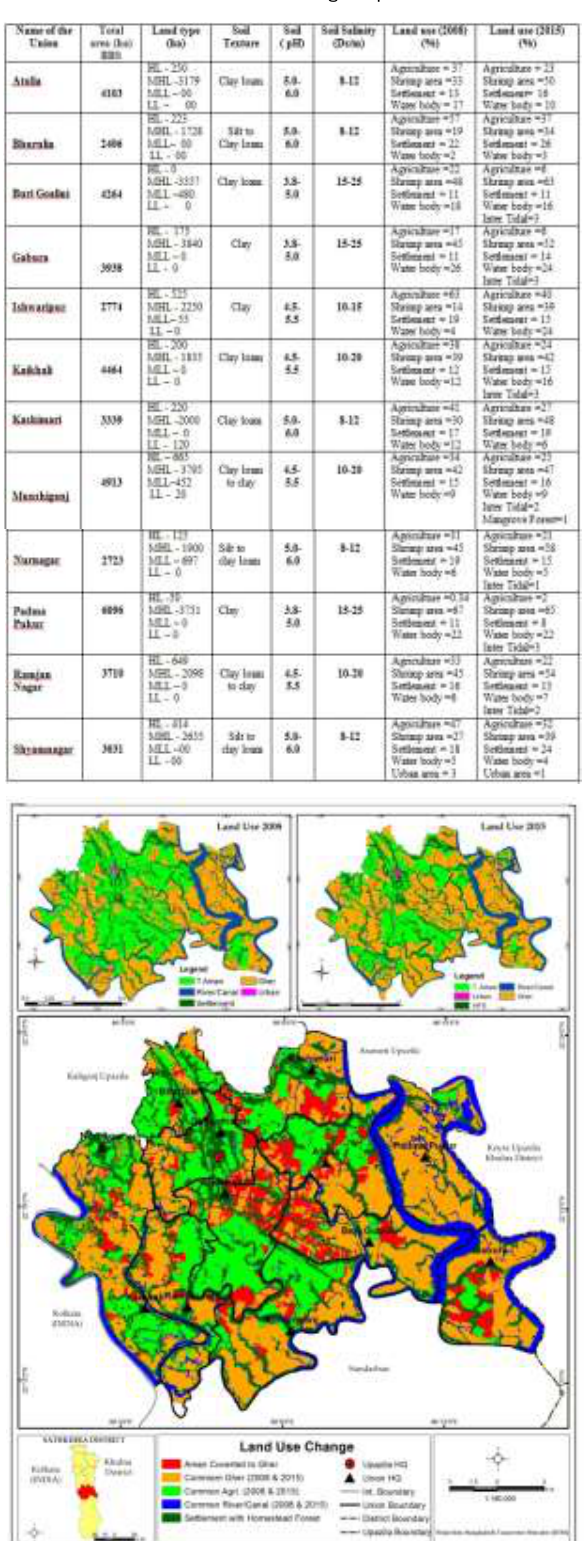
Table 4. Union-wise statistics during the period 2008 and 2015